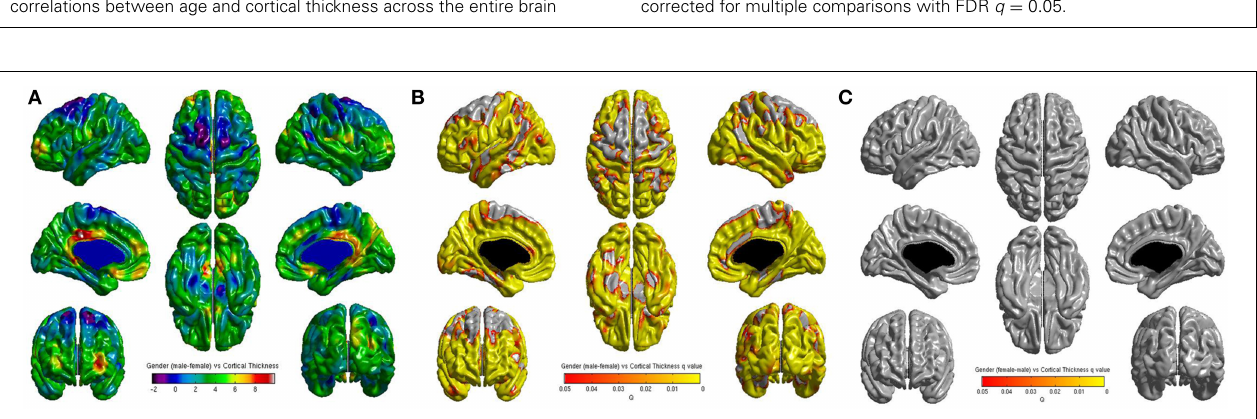
FIGURE 3 | (A) Unthresholded correlations between gender (male—female) and cortical thickness across the entire brain, shown here for comparison. (B) Positive correlations (male—female) between gender and cortical thickness